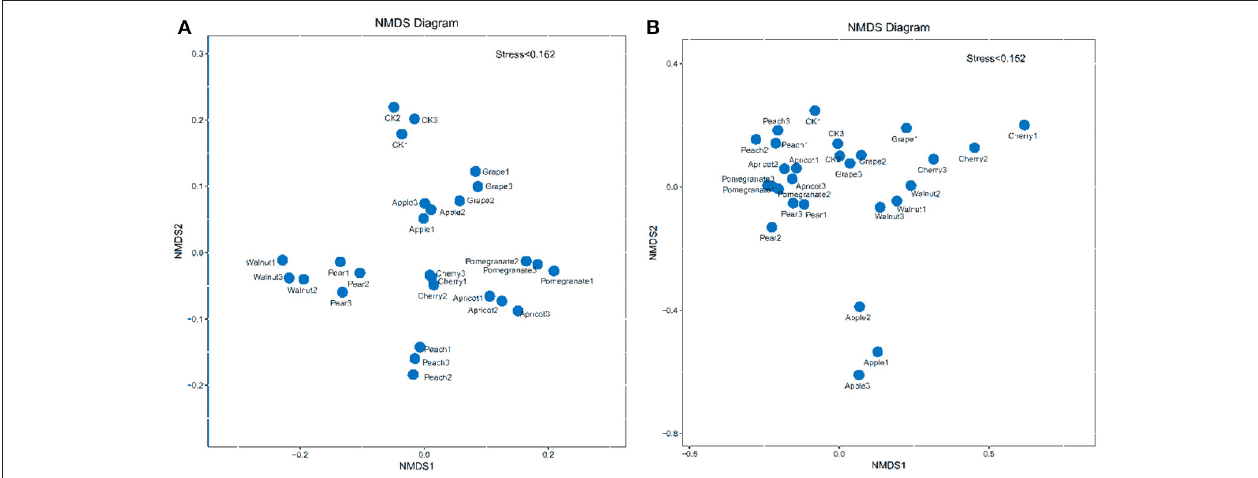
FIGURE 3 | Non-metric multidimensional scaling (NMDS) plots of bacterial (A) and fungal communities (B) .